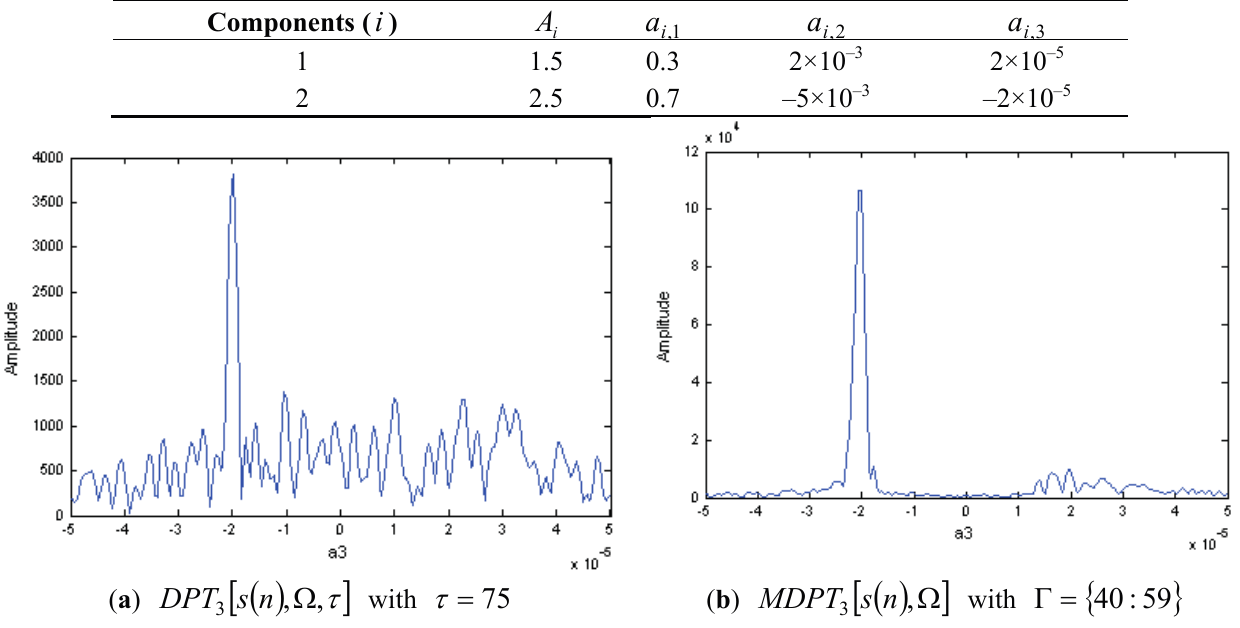
Figure 2. DPT of a two-component LFM signal with different delay parameters. Table 2. Parameters of the two-component cubic phase signal.